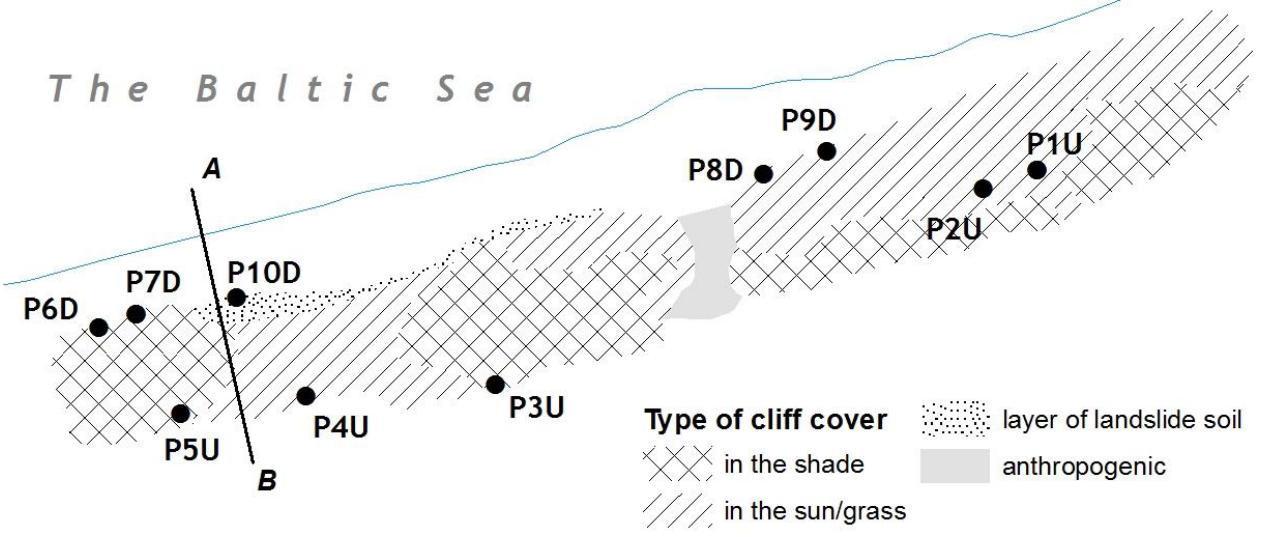
Figure 5. Sampling points for geomats in the complex of the structure engineered to strengthen the slopes in Svetlogorsk (of 1300 m length and up to 140 m width). The outer border of the promenade is taken as the border of the depicted coastline. The line AB shows the cross profile of the slope (Figure 3).